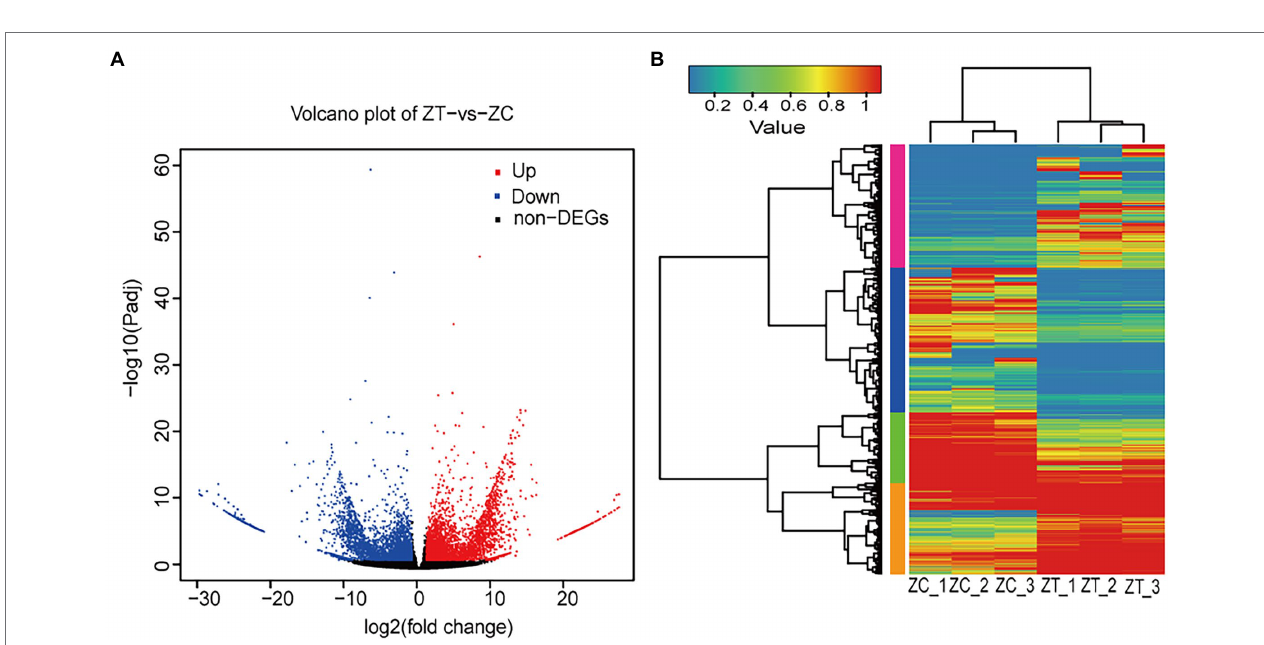
FIGURE 2 | The Volcano plot and Cluster plot of the differential expression isoforms in ZC and ZT samples [ (A) Volcano plot; (B) Cluster plot. ZC: root samples from normal flowering plant; ZT: root samples from early flowering